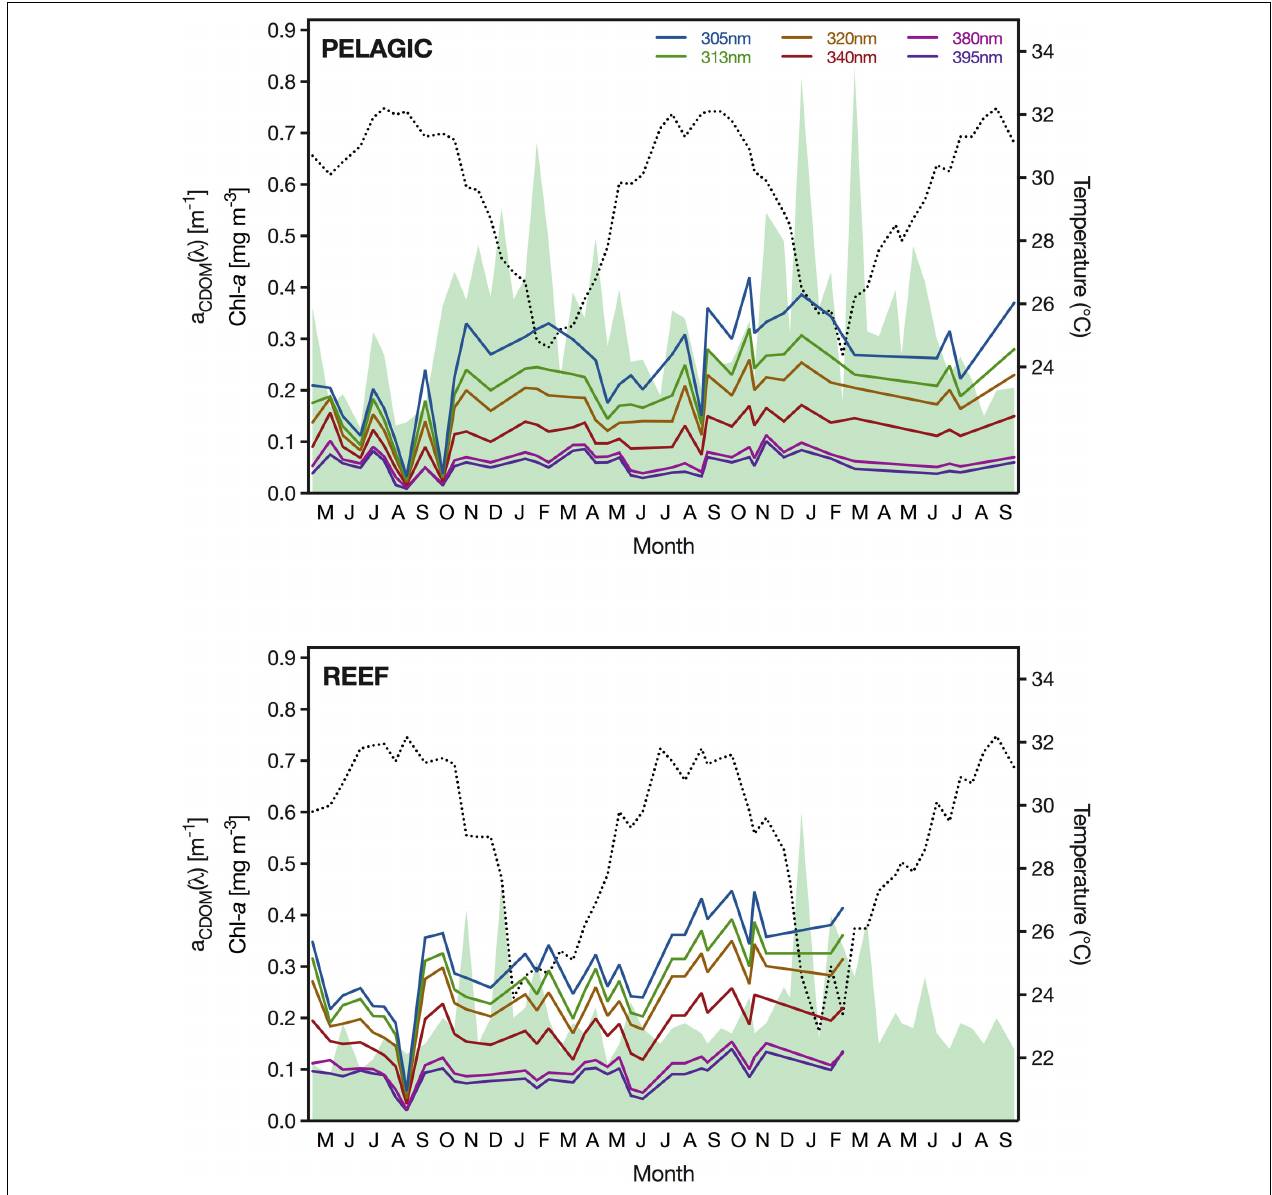
FIGURE 3 | Sea surface temperature (SST) in < 1 m depth (dotted black line), surface concentration of Chl- a (shaded green area) and absorption coefficient of CDOM (a CDOM ) for the wavelengths 305, 313, 320, 340, 380, 395 nm (see figure legend for color coding) between May 2016 and September 2018 at the pelagic sampling station (22.309333 ◦ N, 38.997389 ◦ E) (upper panel) and the reef (22.309333 ◦ N, 38.997389 ◦ E) (lower panel) .